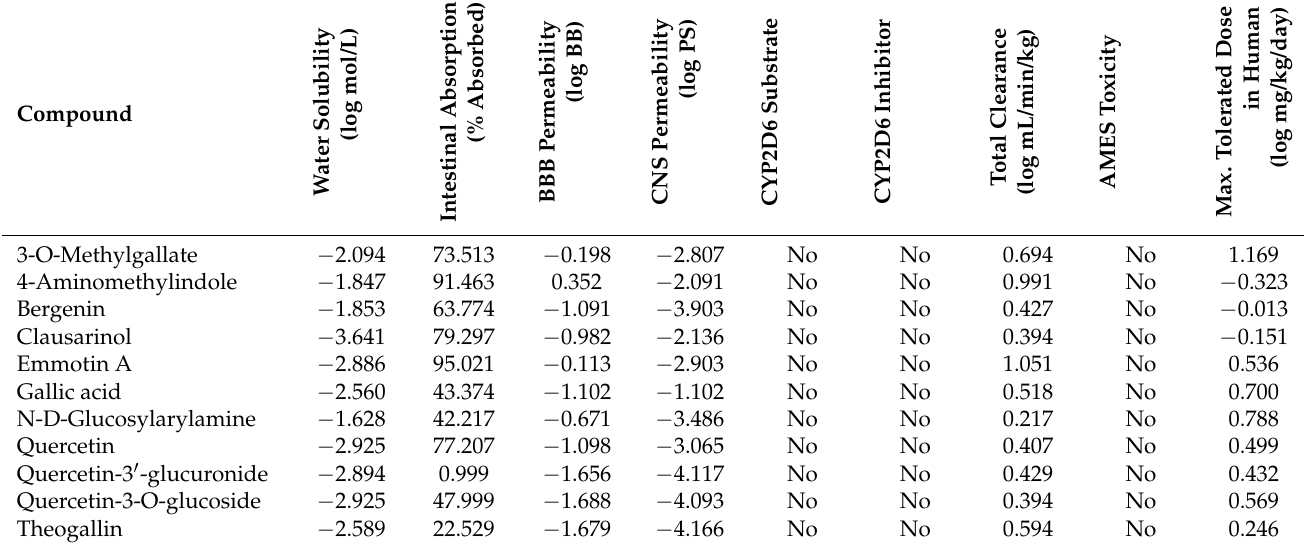
Table 4. ADMET analysis of